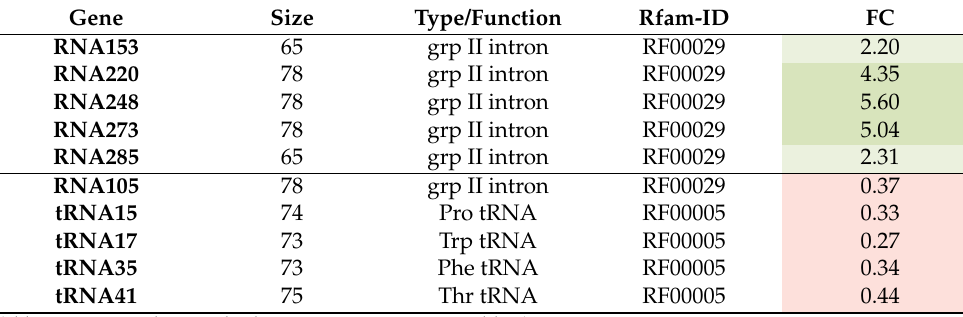
Table 6. Irradiation-induced and repressed RNA genes in P2 but not in P6.